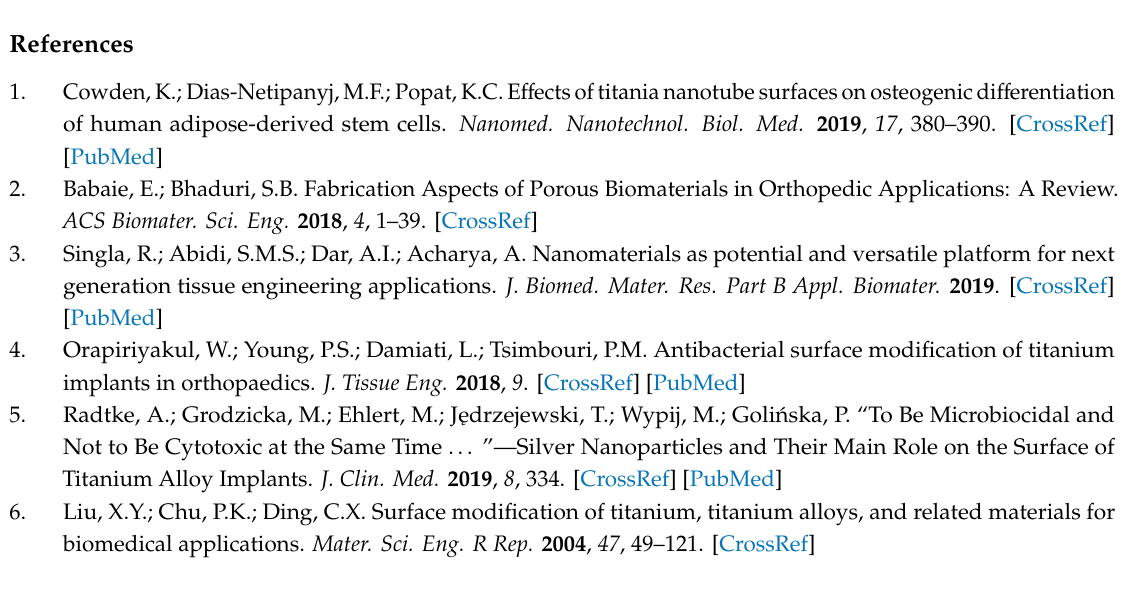
Table S1: Results of contact angle and surface free energy (SFE) measurements; contact angles were measured three times using distilled water and diiodomethane; SFE values were determined using the Owens-Wendt method. Author Contributions: Conceptualization, A.R. and M.E.; methodology, A.R., M.E., K.R., T.J., M.B.;